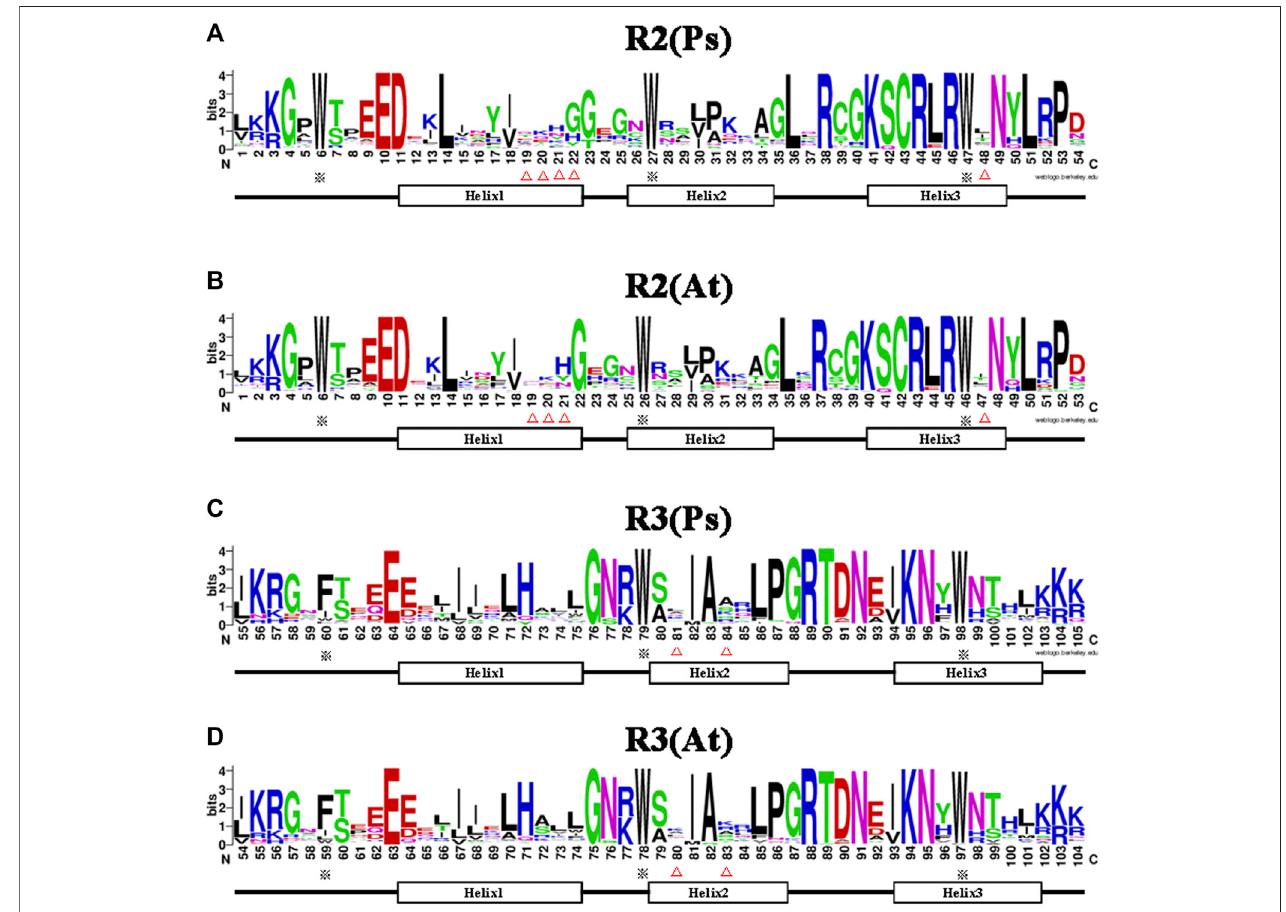
FIGURE2| ComparisonoftheDNA-bindingdomainsinR2R3-MYBproteinsofpeaand Arabidopsis . (A,B) Sequencelogosshowingthe fi rstpart(R2)oftheDNA- bindingdomainsinpea (A) and Arabidopsis (B) . (C,D) Thesecondpart(R3)inpea (C) and Arabidopsis (D) .MYBrepeatsarebasedonfull-lengthalignmentsofallR2R3- MYB domains in these two species. The bit score indicates the information content for each position in the sequence. The position of the three α -helices that form each MYB repeat are marked (Helix 1 – 3). The asterisks indicate the conserved residues in the MYB domain, whereas the different residues in MYB domain of pea and Arabidopsis are marked with triangle